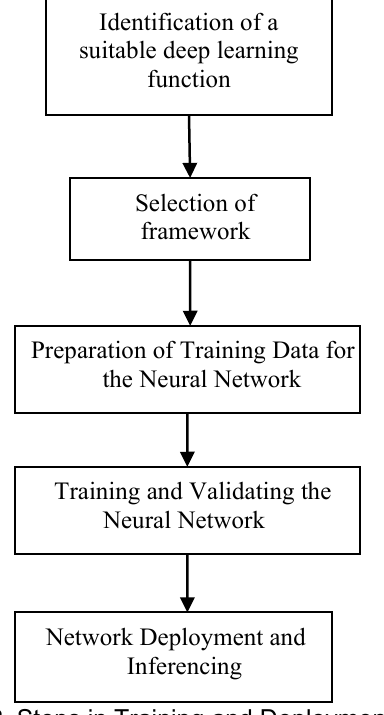
Figure 2. Steps in Training and Deployment of a Neural Network Step 4: Train and validate the neural network to ensure